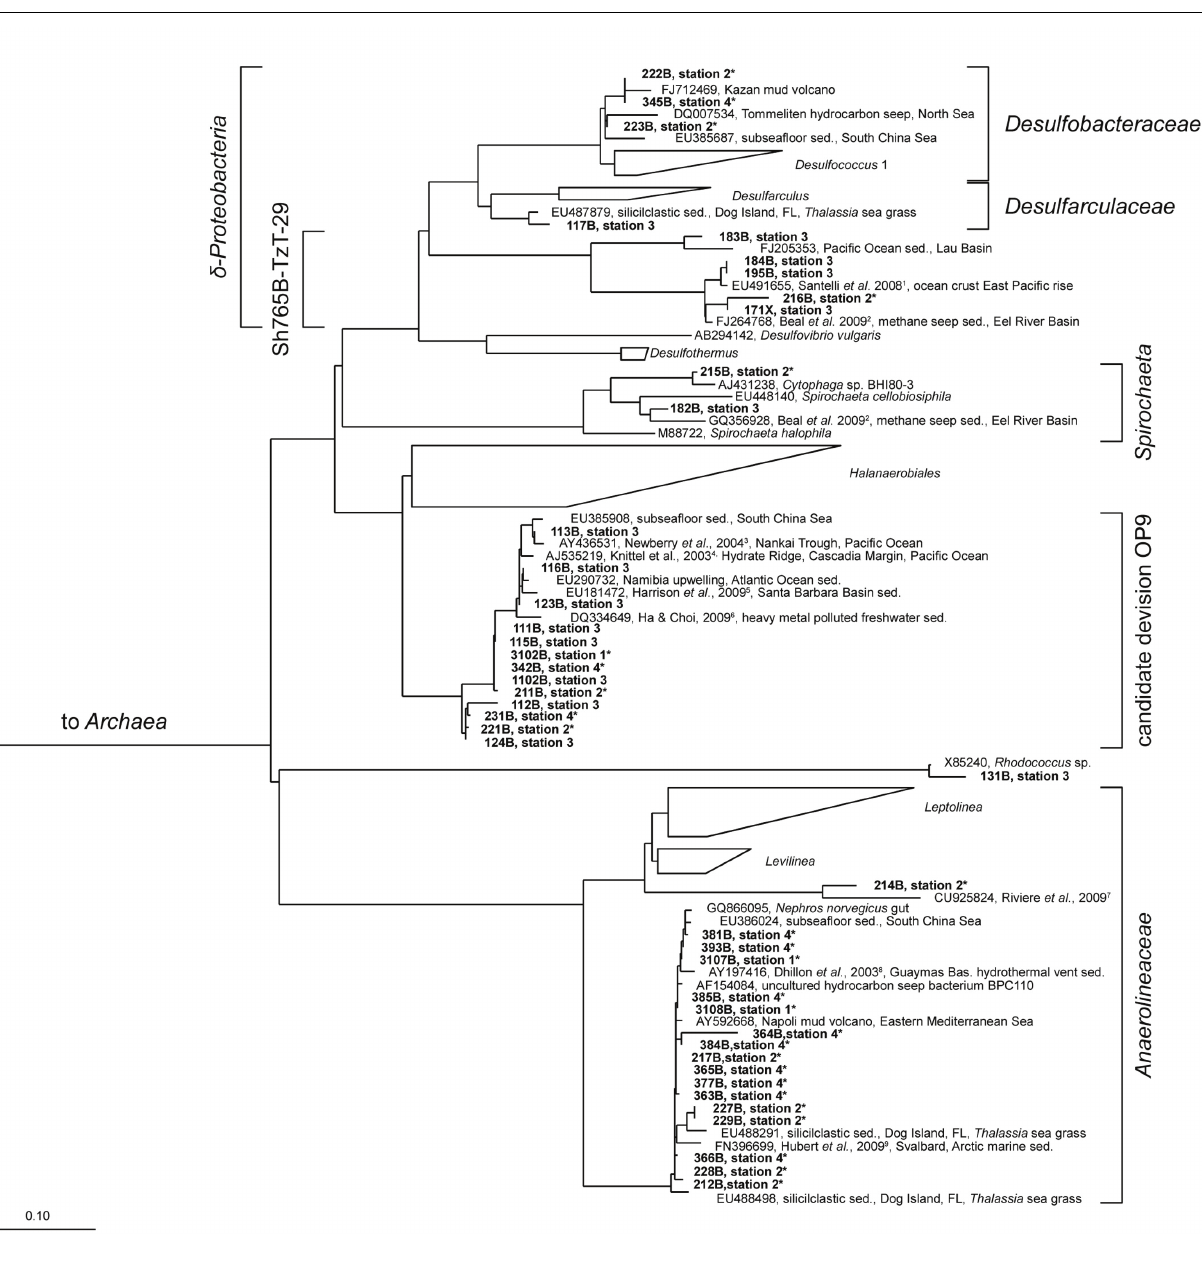
FIGURE 6 | Parsimony tree of bacterial 16S rRNA gene sequences with all sampled stations. The tree is based on the SILVA tree version 102 (Pruesse et al., 2007). Sequences obtained from the Simeulue seep are in bold letters. Bold numbers describe bands excised and used for 16S rRNA gene sequencing from three different DGGE gels. On the right, the deepest